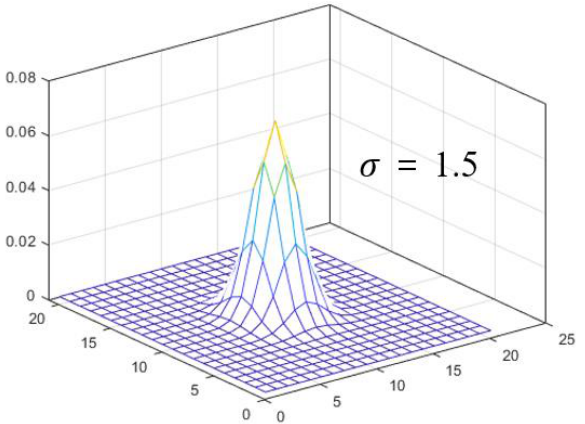
Figure 2. Three-dimensional (3D) plot of the PSF used to convolve the clean image in the simulation study. The PSF is based on a Gaussian distribution with a sigma of 1.5 pixels. Microscopic images of haematoxylin–eosin (H–E) staining in a mouse oral mucosa were acquired for this study. The H–E-stained tissue was produced according to the general histological sample preparation, including fixation in 4% paraformaldehyde, paraffin embedding, tissue sectioning (7 µm), and H–E staining. The microscope images which consisted of a Leica DM500 microscope (40×/0.65 NA/0.31 mm W.D., 100×/1.25 NA/0.10 mm W.D.), Leica ICC50 E camera (Aptina 1/2 inch CMOS sensor, pixel size = 3.2 µm × 3.2 µm, pixel resolution = 2048 × 1536), and Leica LAS EZ software.